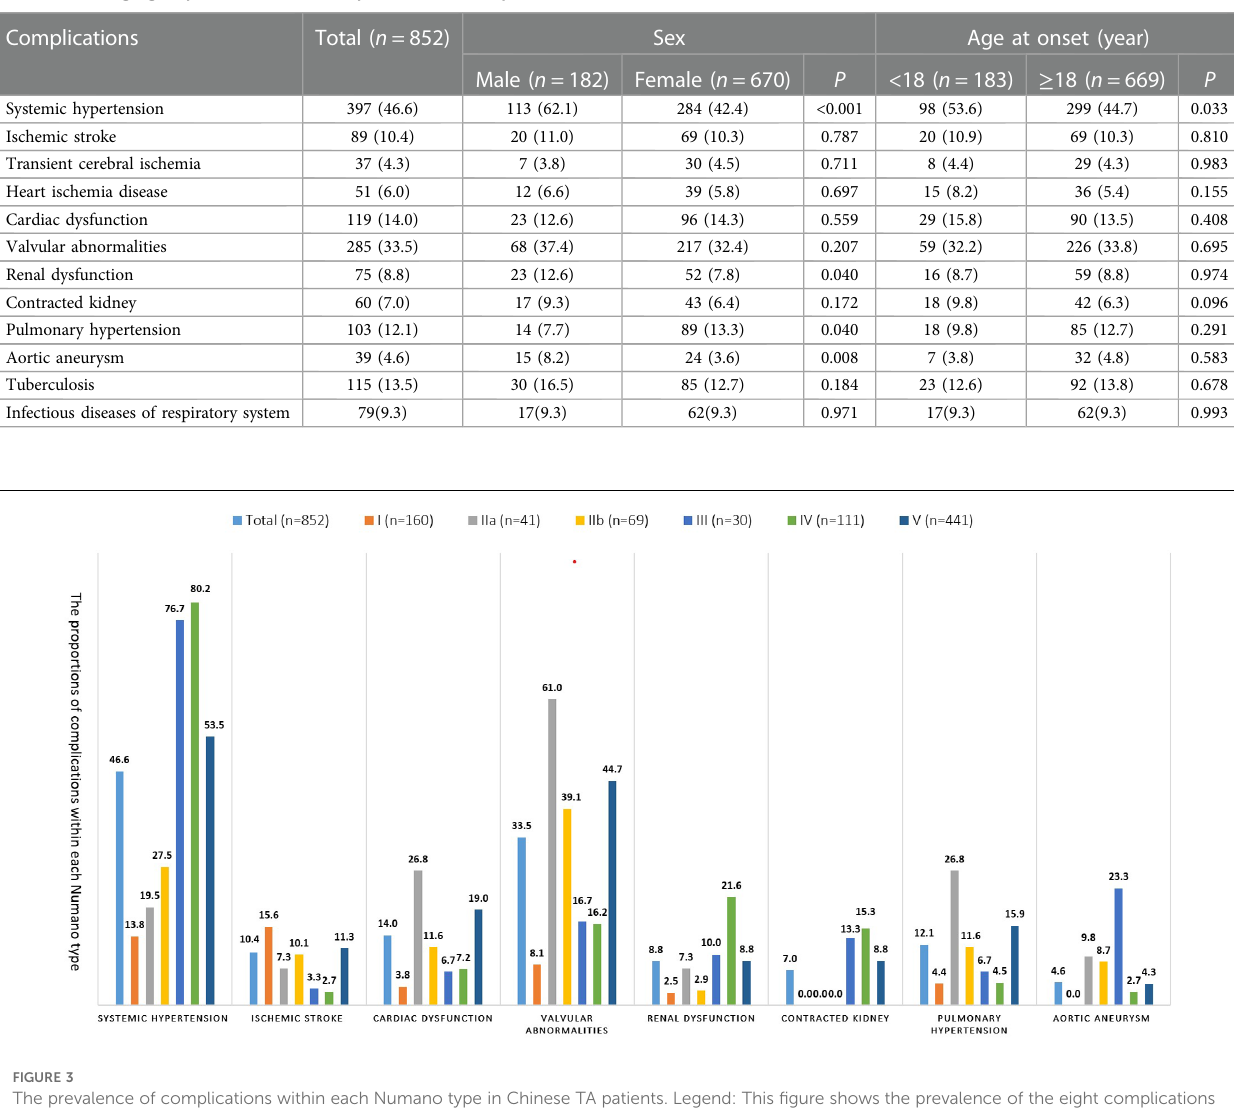
TABLE 3 Sex, age groups of onset and complications in TAK patients [ n (%)].